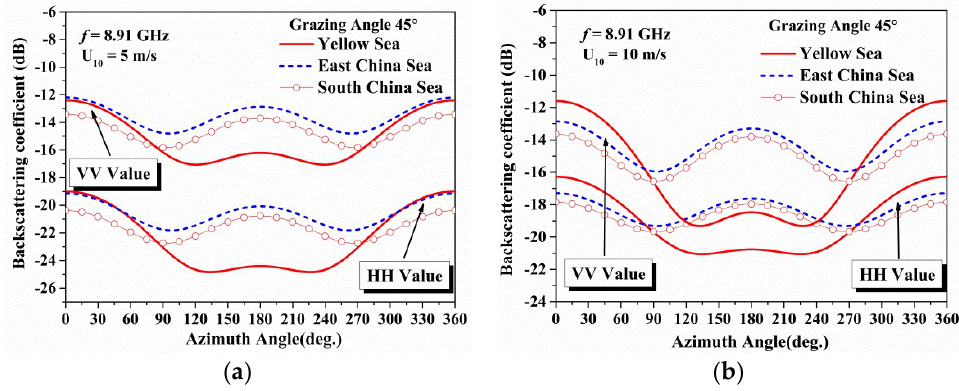
Figure 12. The figures show the azimuth angle variation of the co-polarization backscattering coefficients in different seas: ( a ) Wind speed of 5 m/s; ( b ) Wind speed of 10